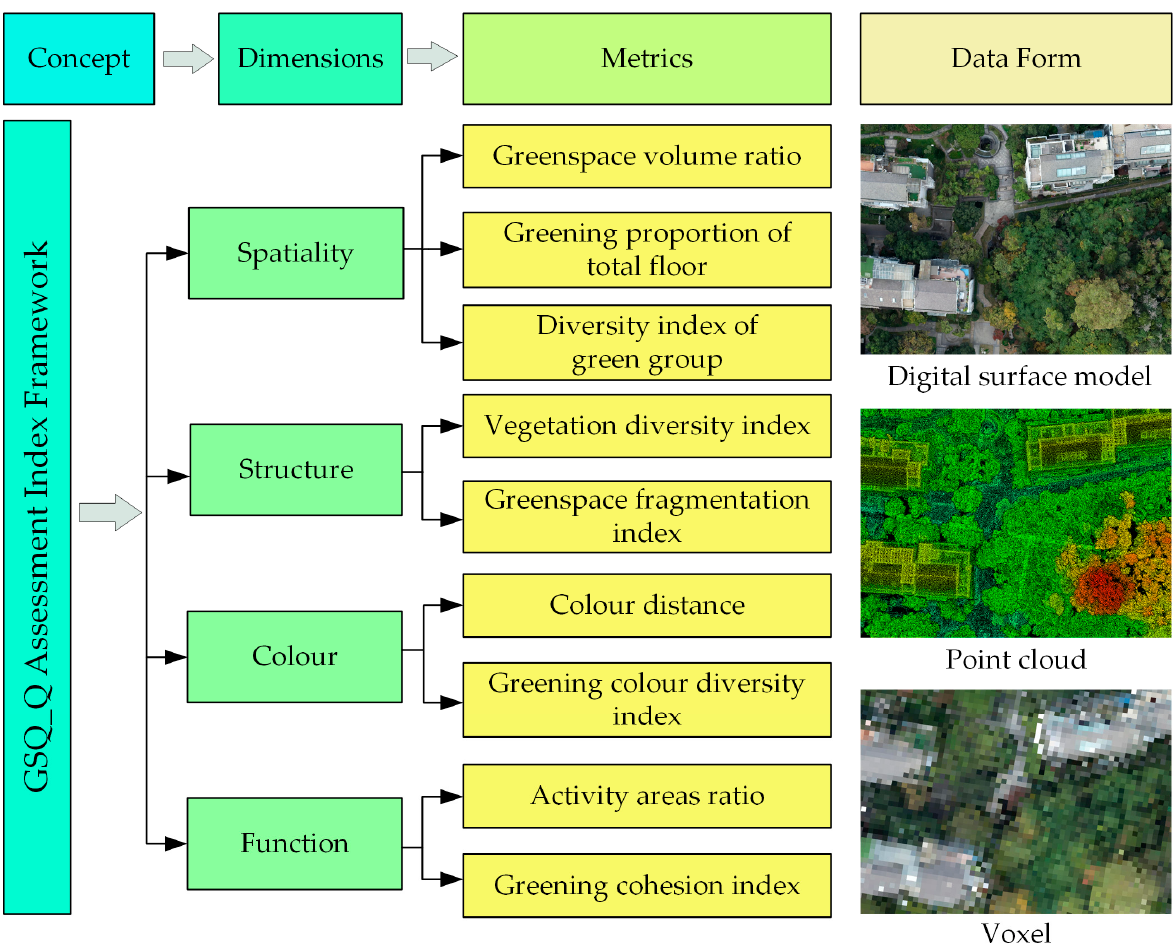
Figure 3. 3 ‐ D spatial metrics representing the greenspace exposure quality. Figure 3. 3-D spatial metrics representing the greenspace exposure